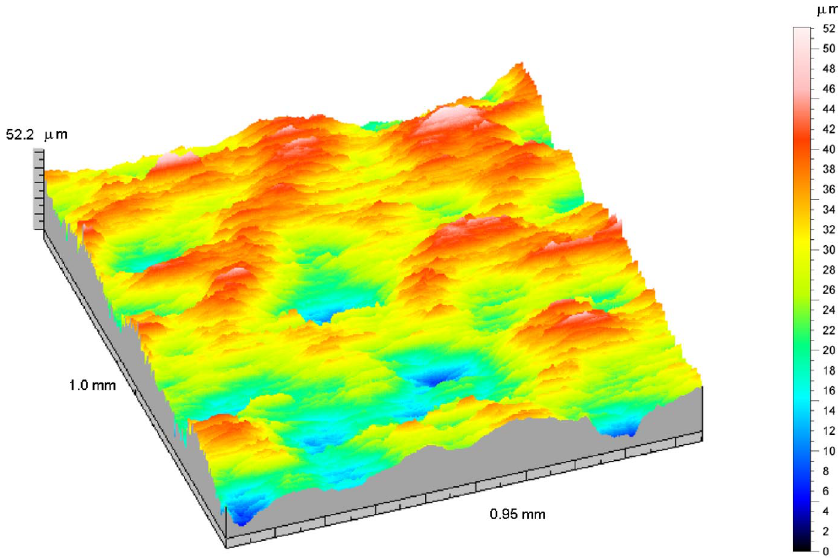
FIG. 5. (Color) Topographic view of a 1 mm (cid:6) 1 mm portion of the interior surface of the RHIC beam pipe obtained by Solarius Development, Inc. [9] with one of their optical